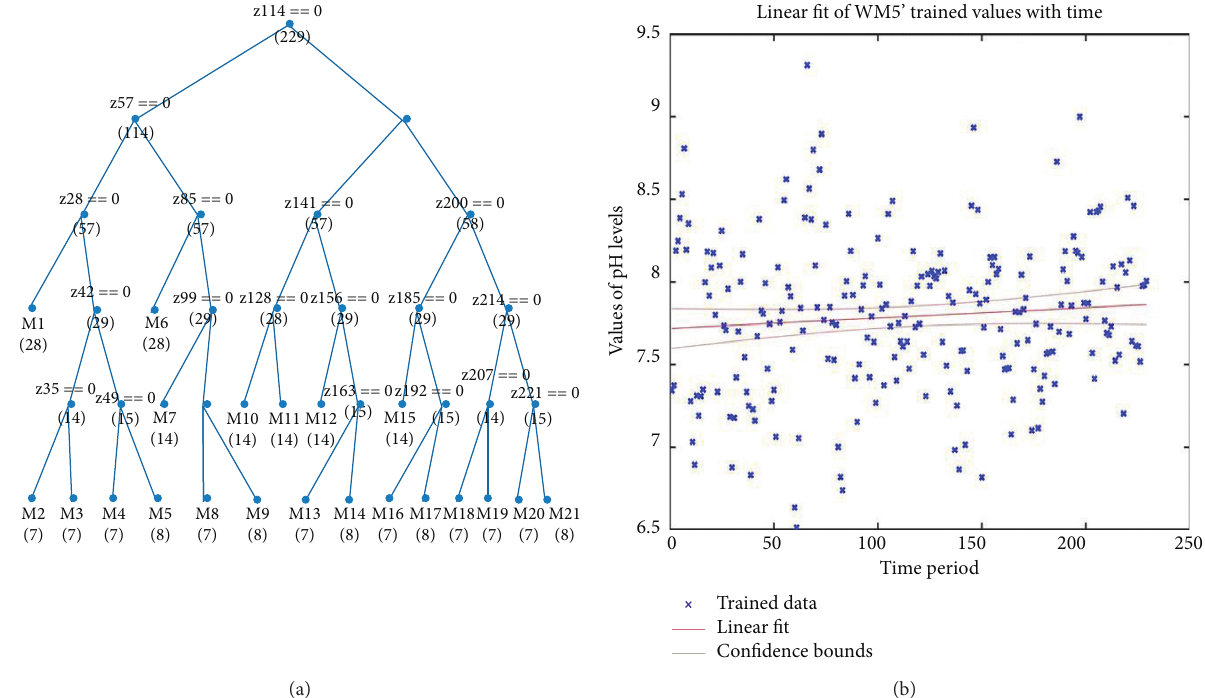
Figure 10: (a) WM5pRT regression tree of pH values at Palla. (b) Linear regression fit of WM5pRT trained pH values at Palla.